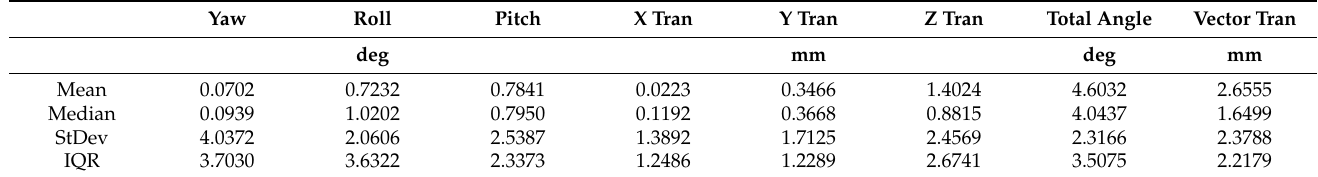
Table 3. Descriptive statistics of the overall roto-translational results of CMSs.